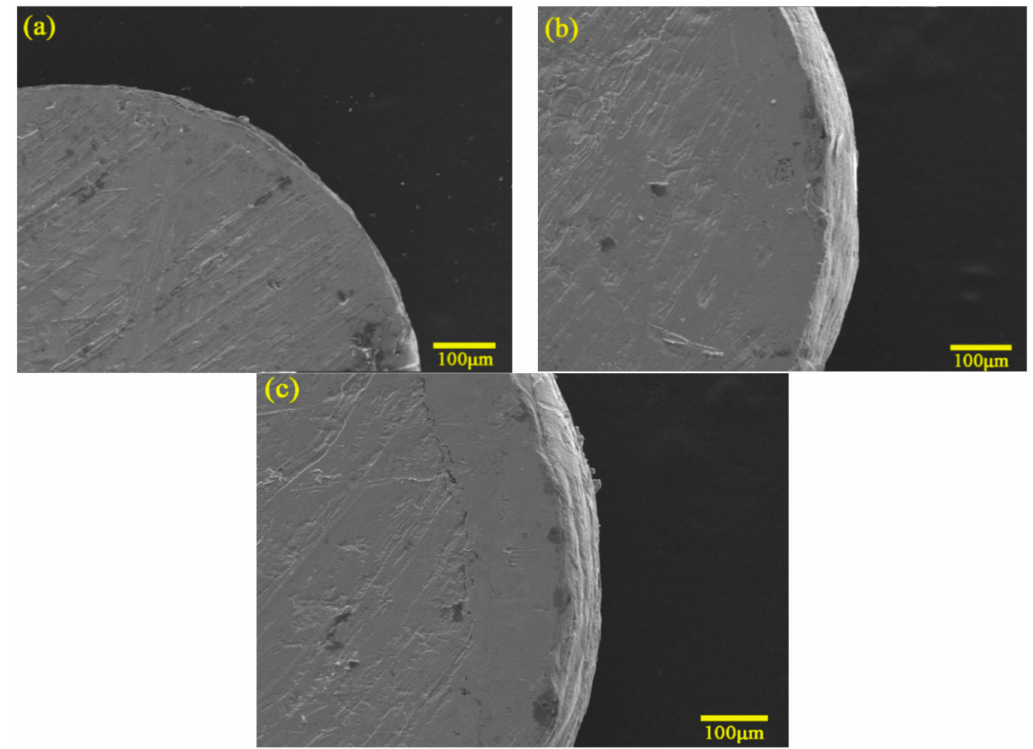
Figure 3. Surface morphology of compressed samples (Ø0.8 mm × 1.2 mm and grain size 30 µ m) under various compression degrees: ( a ) 30%; ( b ) 60%; ( c )